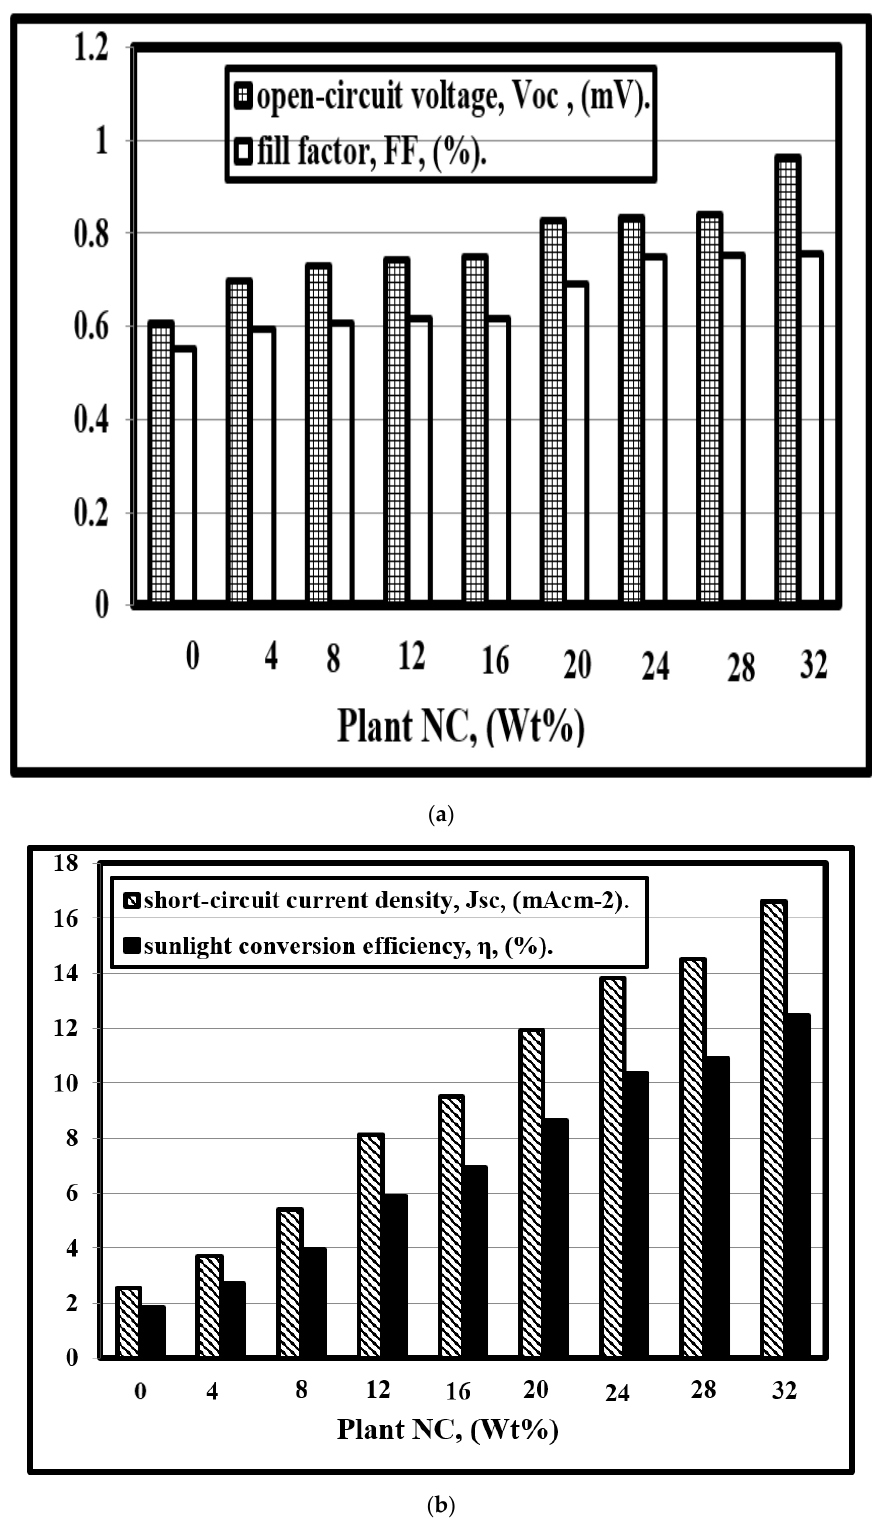
Figure 12. Effect of the PNC content on ( a ) V oc and FF, and ( b ) J sc and η .